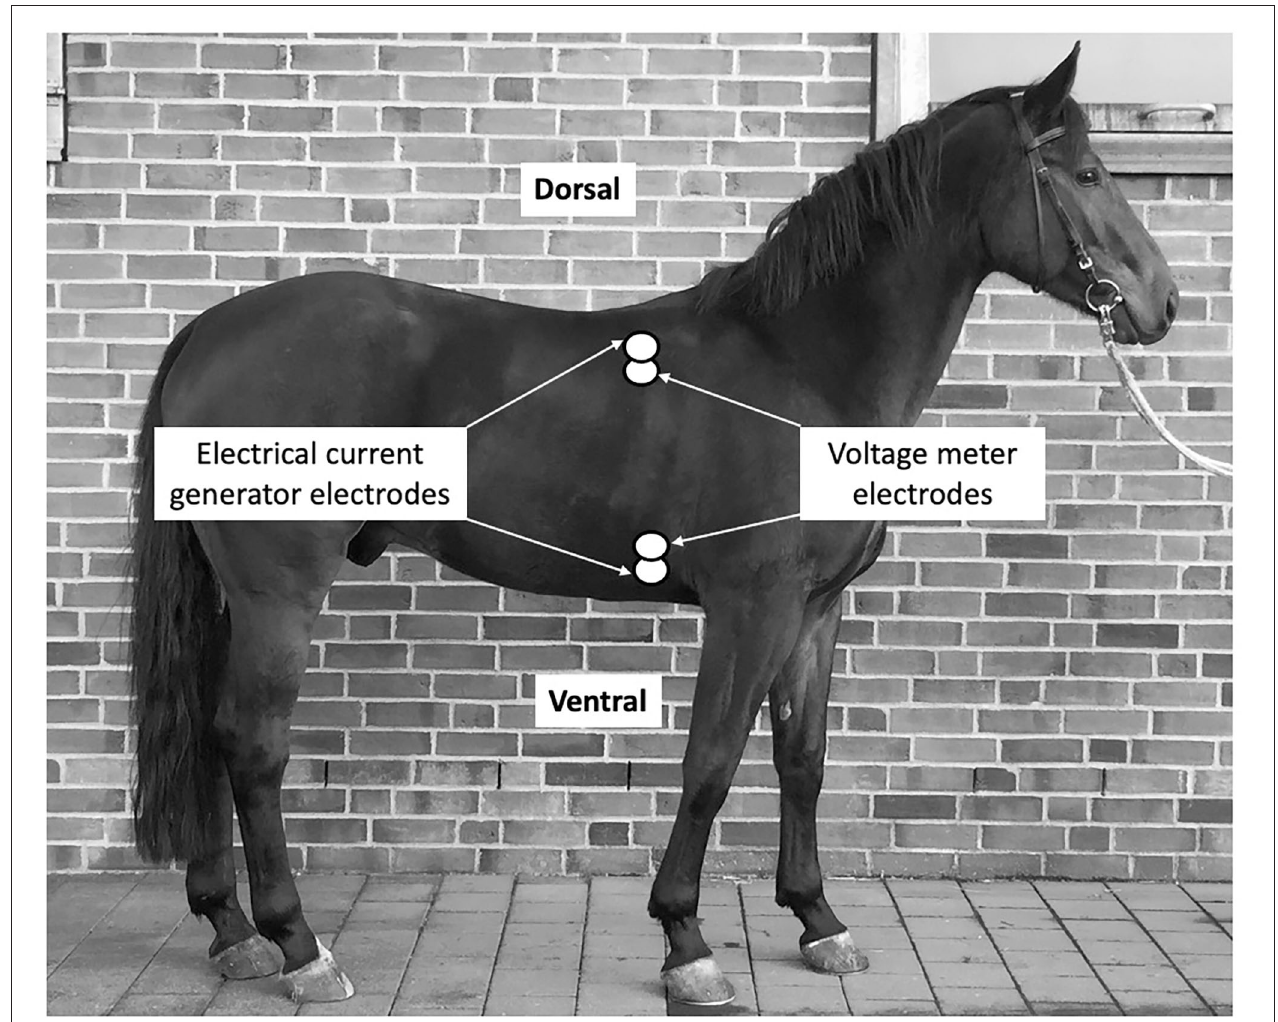
FIGURE 1 | Placement of the sensor stickers on the right side of the thorax of the horse. Sensors are indicated be white double-circles.